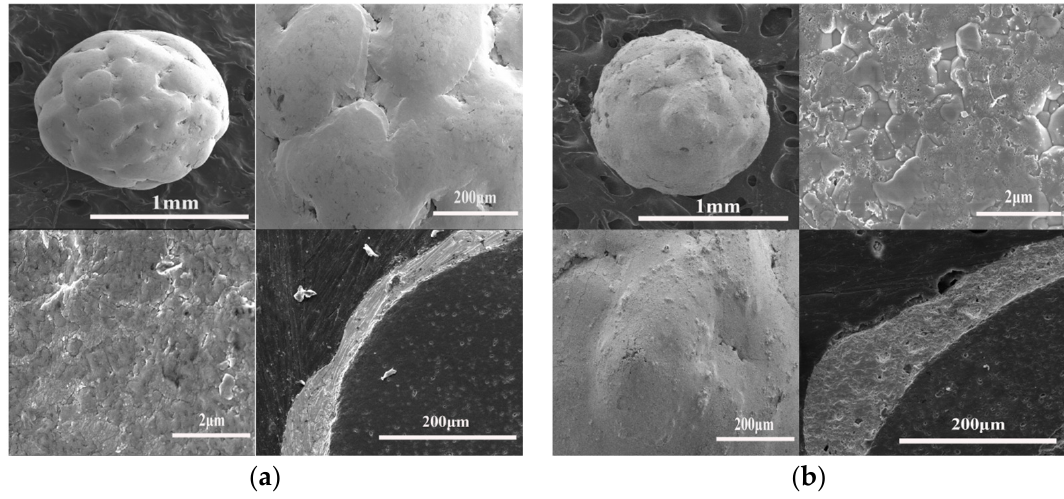
Figure 2. The surface and cross ‐ section morphologies of ( a ) Bi coatings and ( b ) BC ‐ 873 ‐ 5.